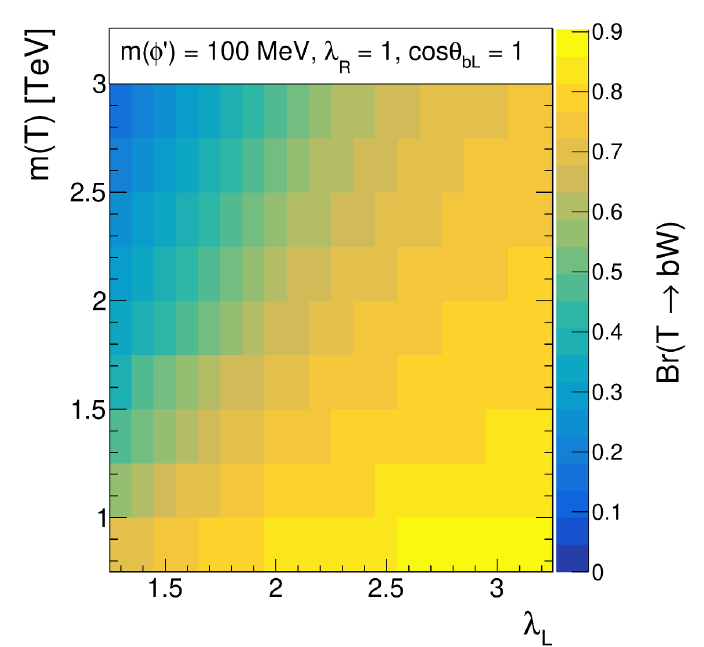
Figure 12 . T → bW branching fraction as a function of m ( T ) and λ tL , for the benchmark scenario with m ( φ 0 ) = 100 MeV and λ tR = 1 (assuming no mixing between the b -quark and new heavy